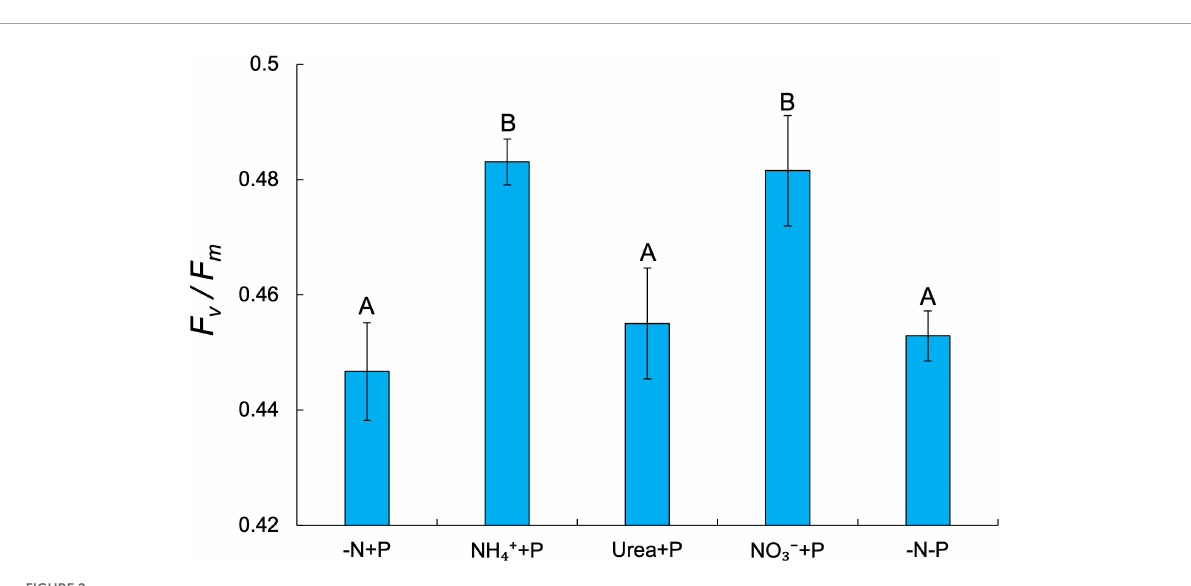
a function of mean abundance of annotated gene